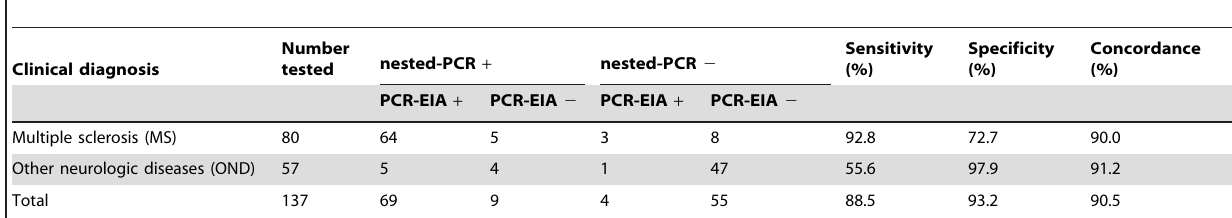
Table 1. Sensitivity and specificity of qualitative PCR assays (PCR-EIA versus nested-PCR) for detection of C. pneumoniae DNA in CSF specimens.